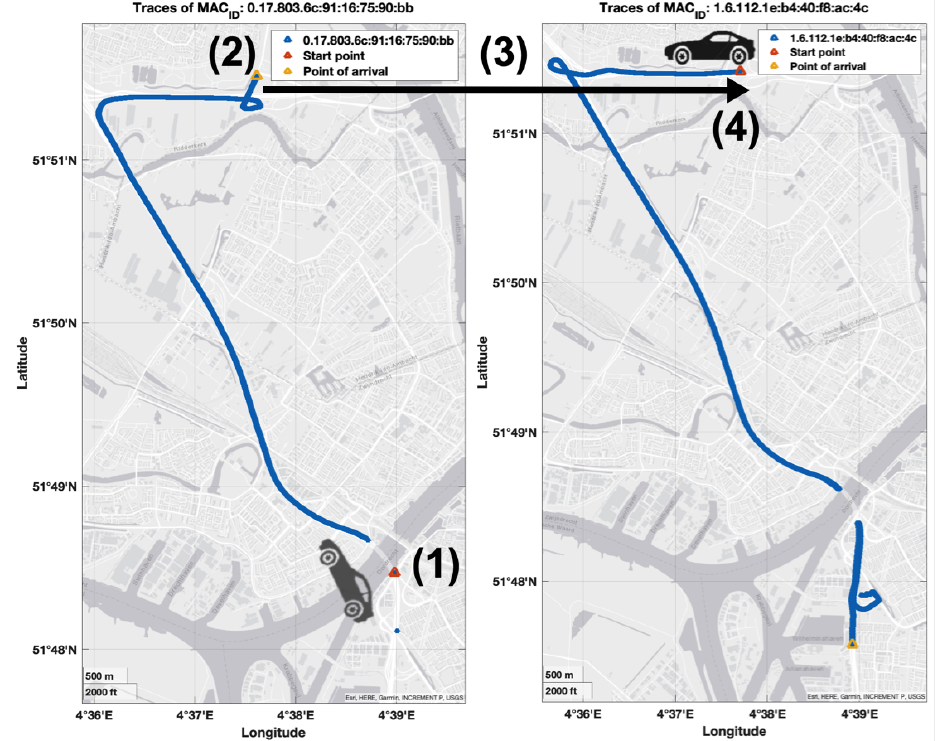
Figure 9. Cluster 2: medium